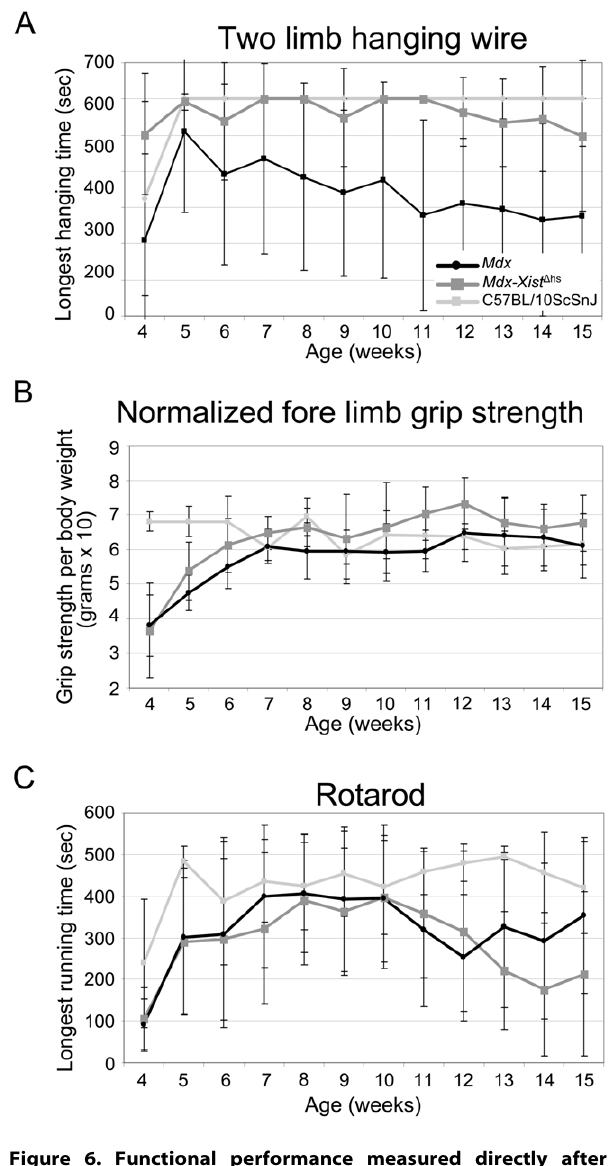
Figure 6. Functional performance measured directly after treadmill exercise. A. Longest hanging time with the two limb hanging test was achieved by wild type and mdx-Xist D hs mice which both performed significantly ( P , 0.001) better than mdx mice. B. Fore limb grip strength of mdx-Xist D hs mice was significantly ( P , 0.001) better than that of mdx mice. C. Wild type mice outperformed mdx and mdx-Xist D hs mice on the rotarod, while no significant difference was observed between mdx and mdx-Xist D hs mice. Average dystrophin level of mdx-Xist D hs mice was 21% (2%–45% median 25.8).